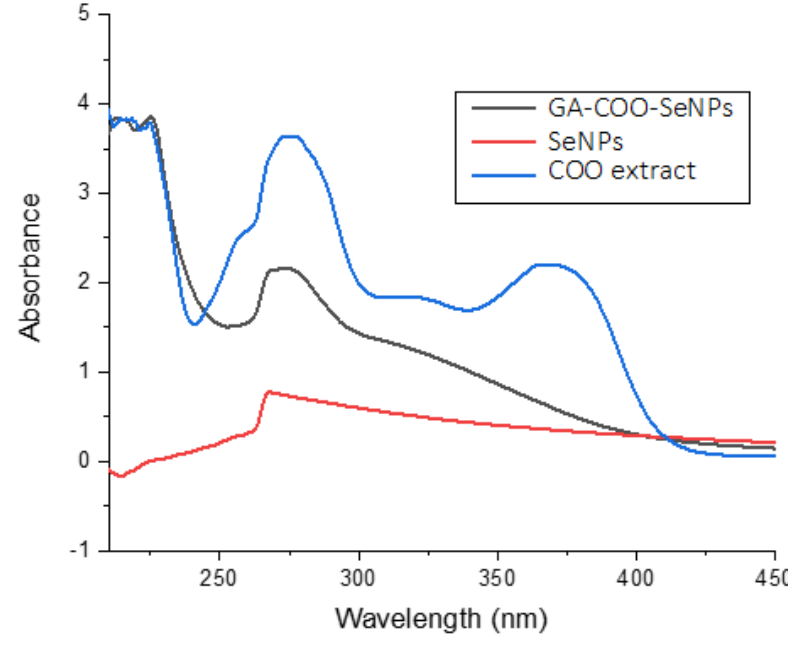
Figure 4. UV–Vis spectra of GA-COO-SeNPs, SeNPs, and COO extract.